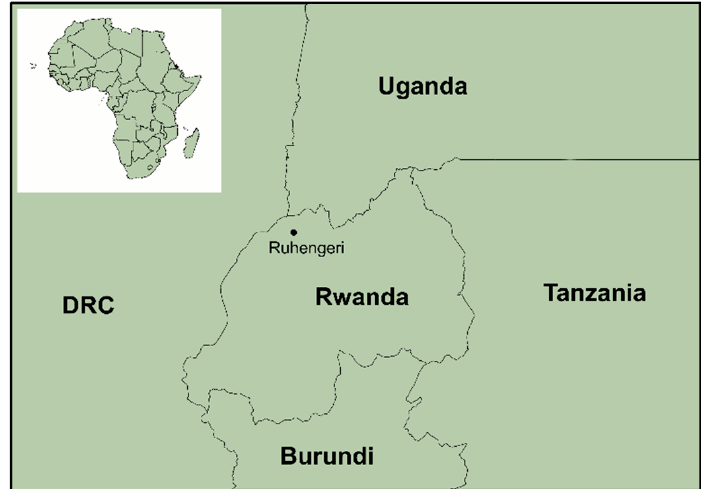
Figure 1. A map of Rwanda and bordering countries. The black dot indicates the site of the two caves in Ruhengeri where sampling was conducted. Map generated using the QGis